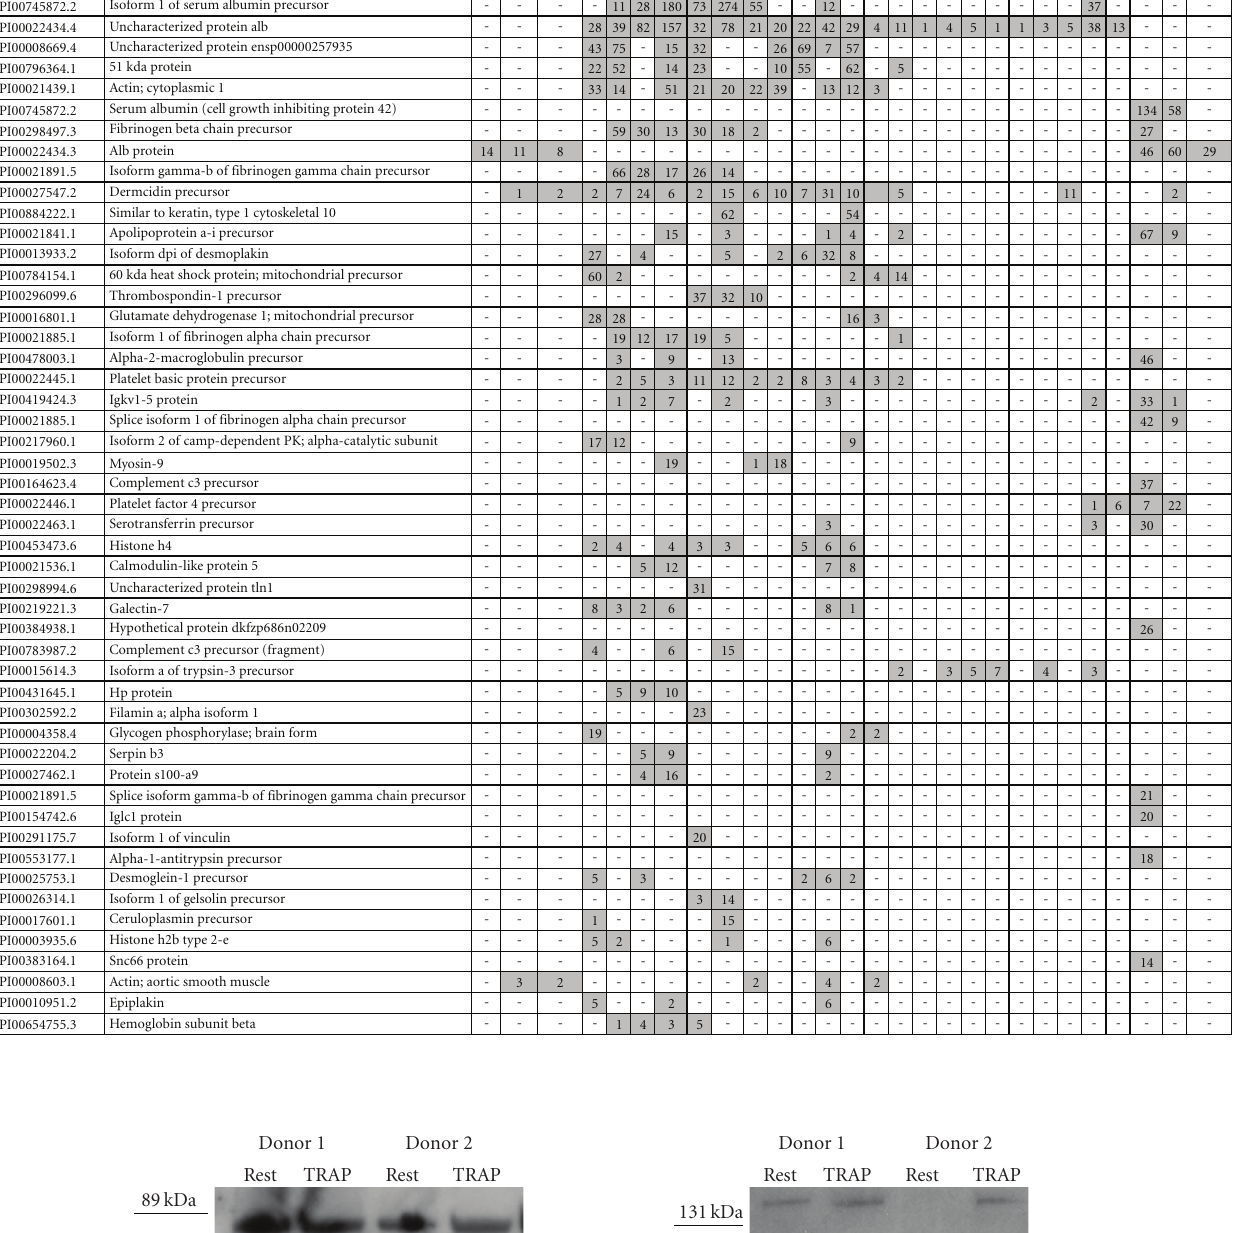
Table 1: Most abundant 50 proteins determined in the study (fractions 1–49).